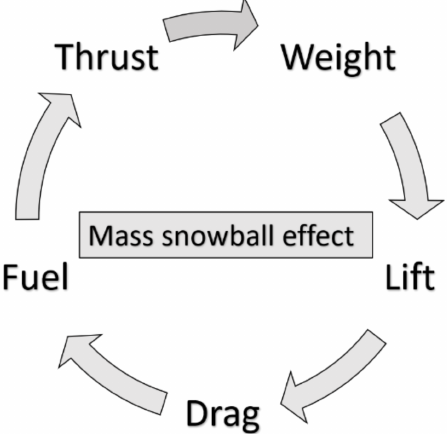
Figure 3. Representation of the mass snowball